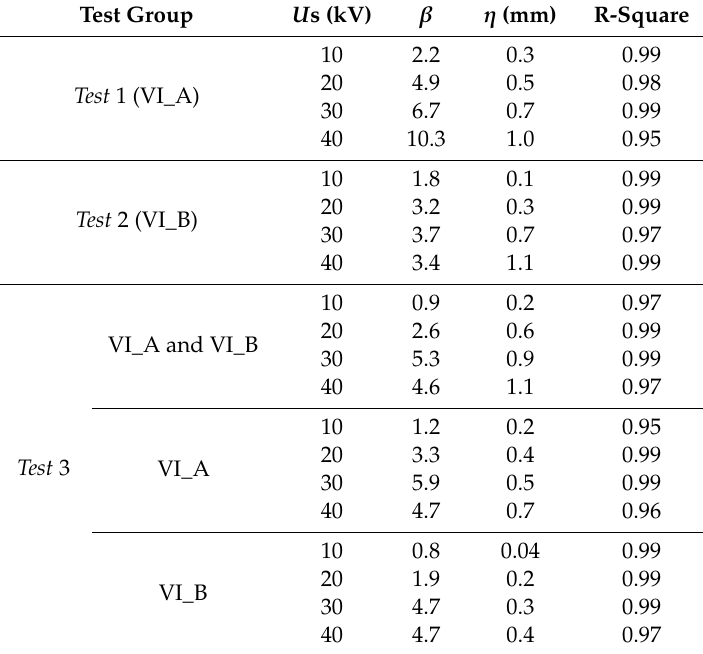
Figure 6. The complementary cumulative distribution function of prestrike gaps in Test 3 with VI_A and VI_B in series: complementary cumulative distribution function (CCDF) of prestrike gaps in VI_A ( a ), in VI_B ( b ), and CCDF of the total prestrike gaps ( c ). Table 2. Values of the Weibull parameters.